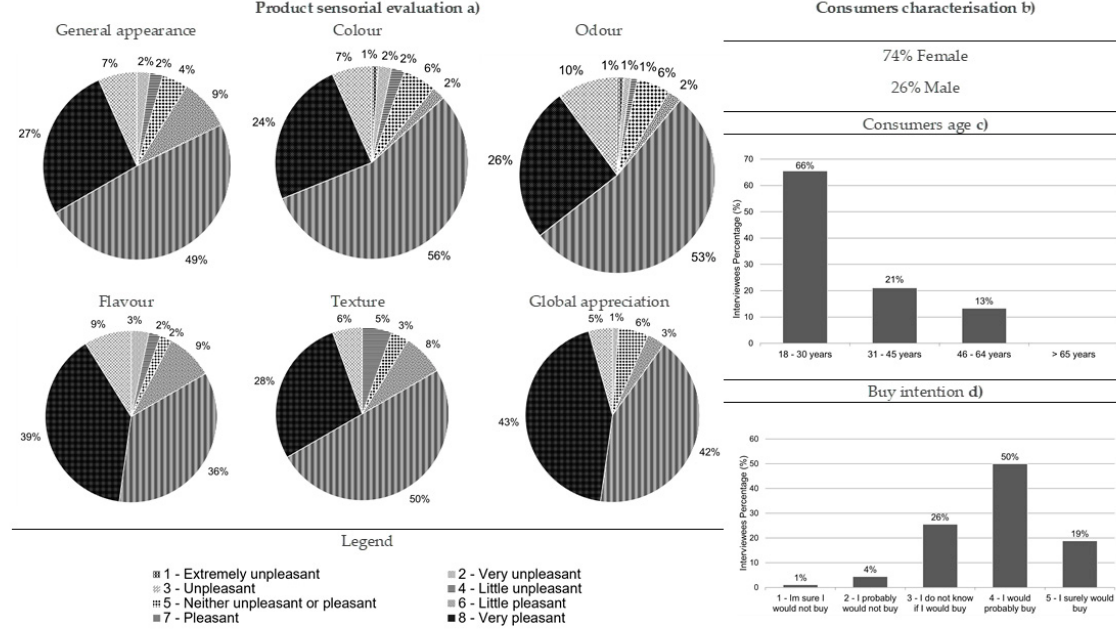
Figure 6. Results from the fried boarfish consumer acceptance survey: ( a ) sensorial evaluation (product’s general appearance, colour, odour, flavour, texture and global appreciation), ( b ) consumers characterisation (gender percentage), ( c ) consumers age and ( d ) buy intention ( n = 90).